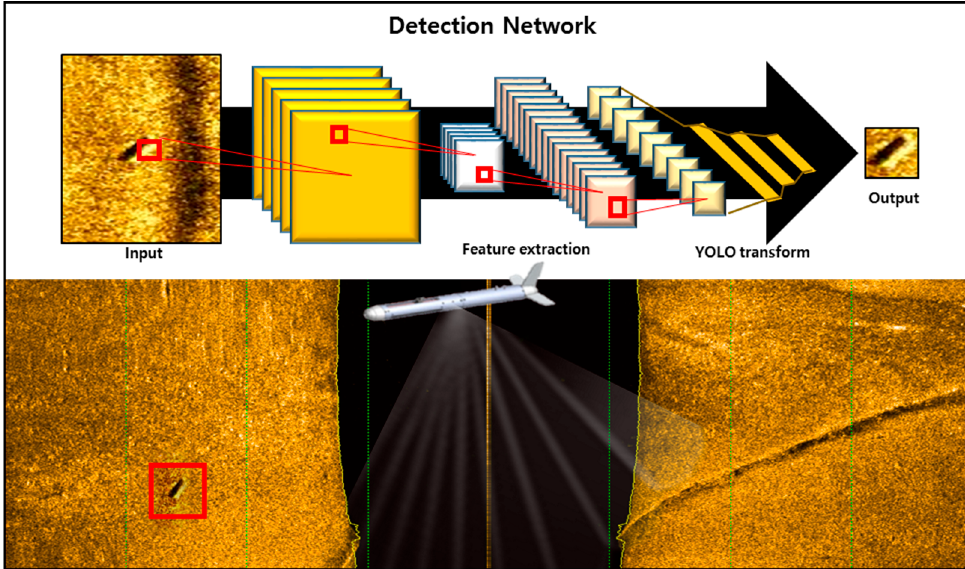
Figure 8. Schematic diagram of YOLO (You Only Look Once)-based detection network for a side scan sonar image.